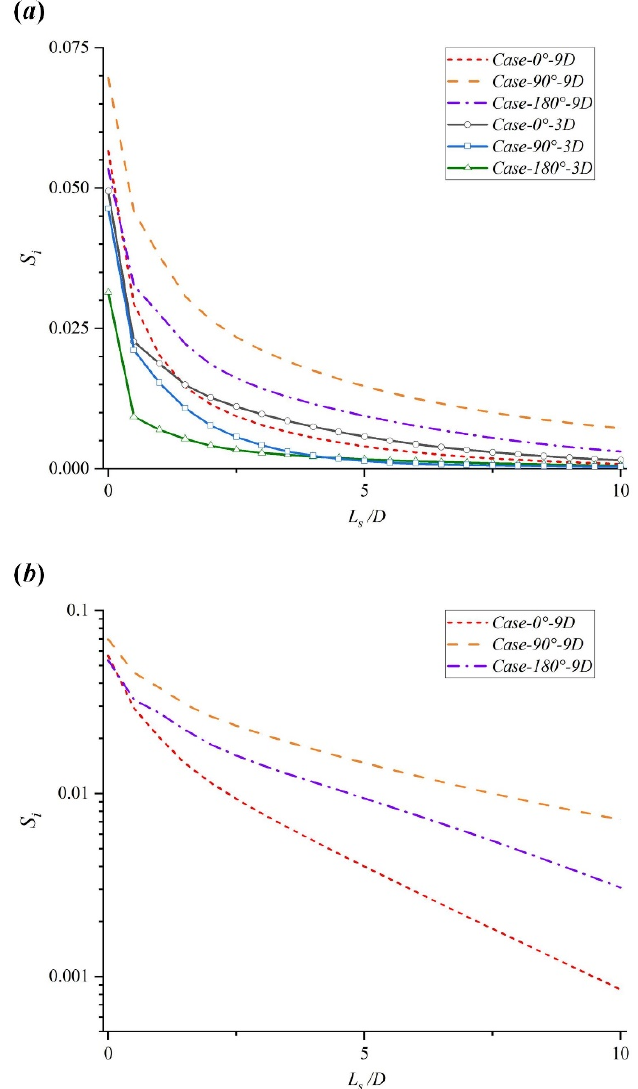
Figure 15. Dissipations of swirl intensities downstream the second bend: ( a ) comparisons of Cases-9D and Cases-3D ; ( b ) results of Cases-9D in a logarithmic coordinate.